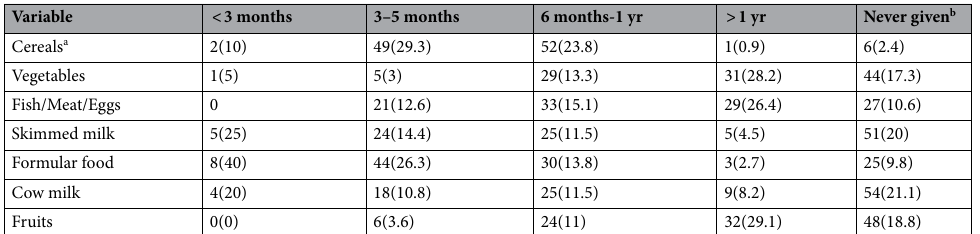
Table 3. Timing of introduction of complementary food items (n = 110). a Including rice, fermented cereal gruel made from maize, millet or guinea corn (pap). b Complementary feeding had not yet been introduced to the infant when mother filled the